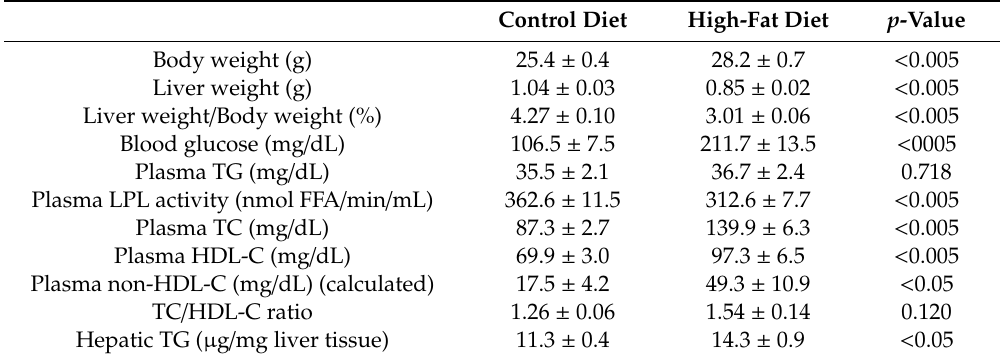
Table 1. Biochemical characteristics of control and HFD-fed mice. C57BL / 6J male mice were fed a control diet or a high-fat diet for four weeks. After an 8-h fast, the mice were sacrificed, and blood and tissue samples were collected for biochemical